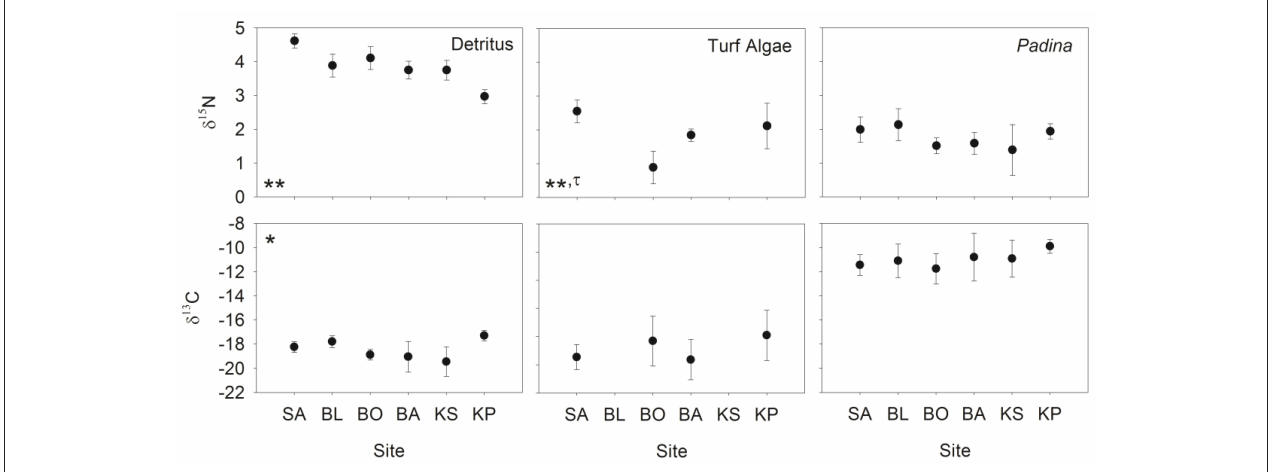
FIGURE 3 | Mean ( ± SD) δ 13 C and δ 15 N of detritus, turf algae and Padina . Sites are ordered left to right increasing in distance from the mainland. Asterisks indicate significance level in ANOVA (* p < 0.01, ** p < 0.001) and tau indicates significance in the Levene’s test ( τ : p < 0.05).